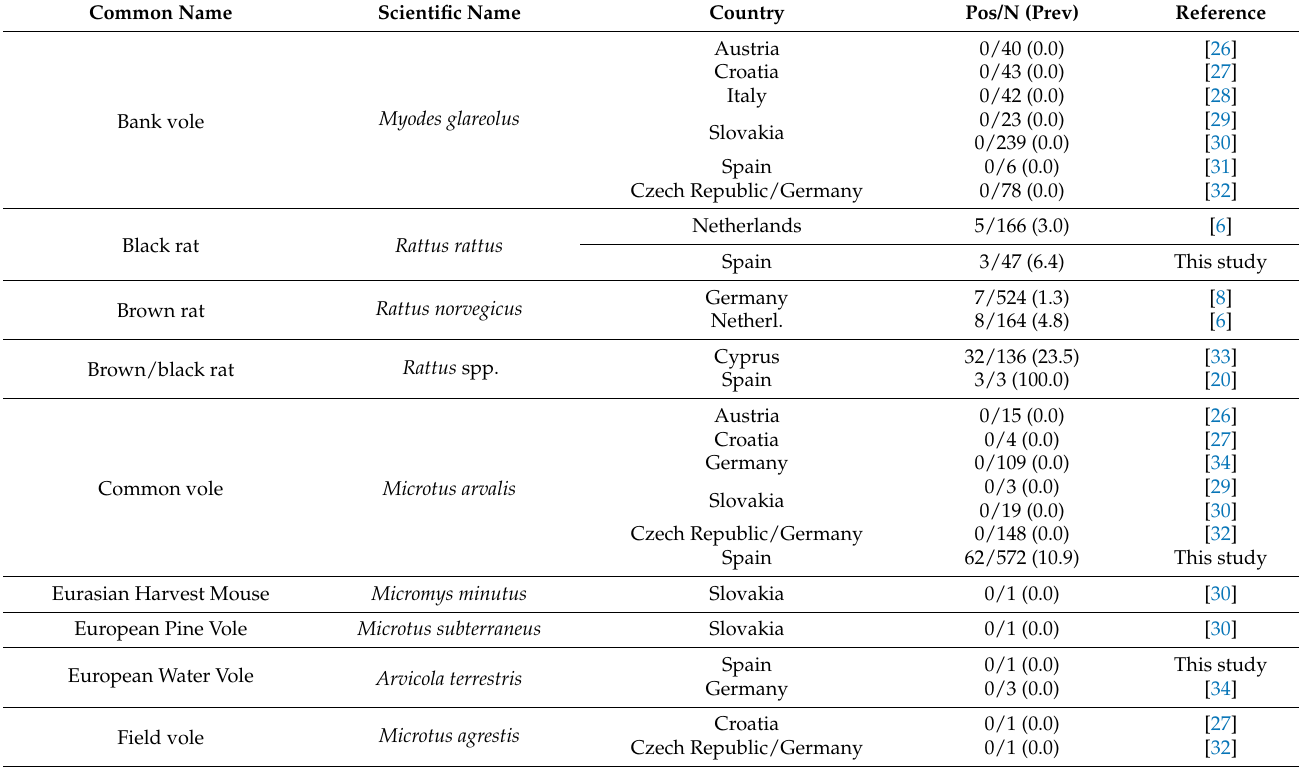
Table 3. Review of current evidences of Coxiella burnetii DNA detection in European micromammal species. Common